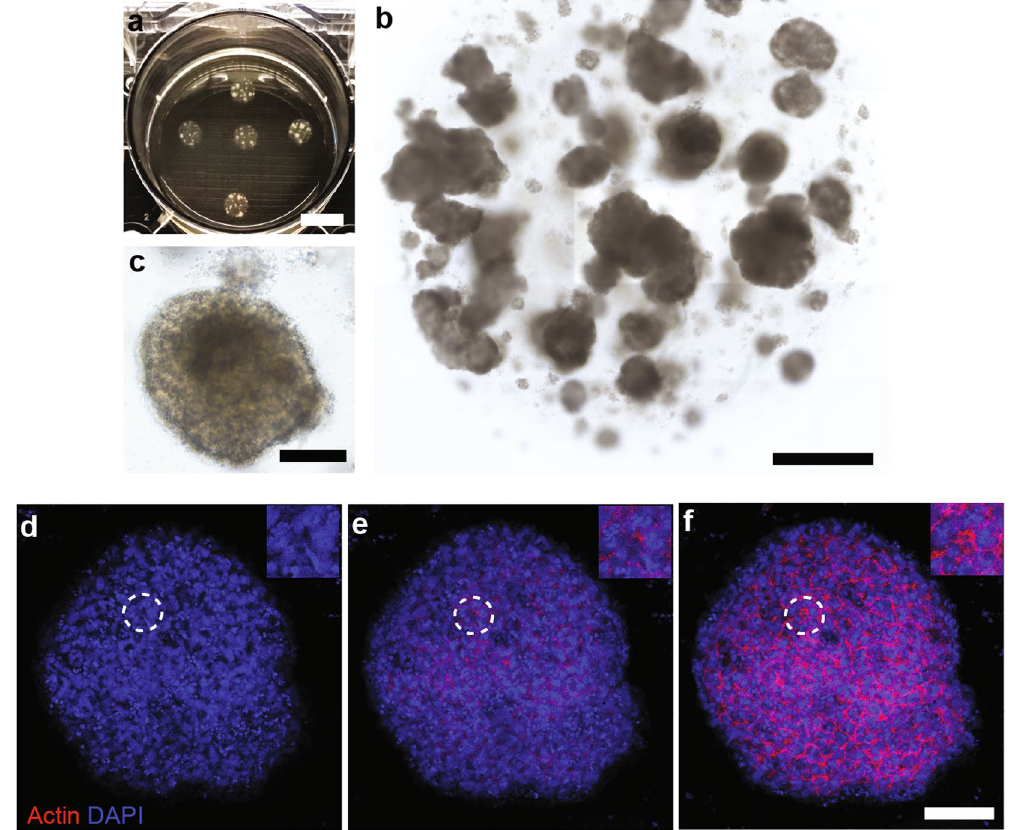
Figure 1. Establishment of retinoblastoma organoid culture. ( a ) Photograph of retinoblastoma organoids grown in Matrigel ® drops. ( b ) Mosaic image shows multiple organoid sizes in a single Matrigel ® drop; typical growth features of a 3-week culture after passaging. ( c ) Magnified micrograph of organoid showing dense cellular organization. ( d – f ) Confocal z-plane images of whole-mount organoid (bottom to top), stained with phalloidin and 4 ′ ,6-diamidino-2-phenylindole (DAPI), showing multiple rosette formation (dashed-line circles indicate inserted images). Scale bar, 1 cm ( a ); 1000 µ m ( b ); 200 µ m ( c ) and 100 µ m ( d – f ).